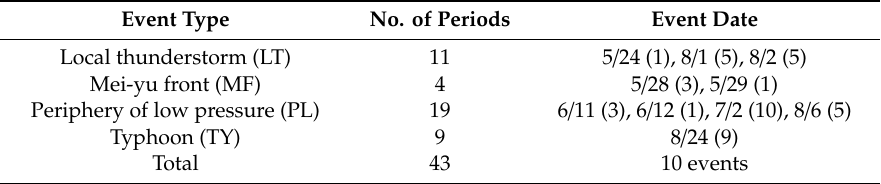
Table 1. The classification of the sampled heavy rainfall events in 2019.